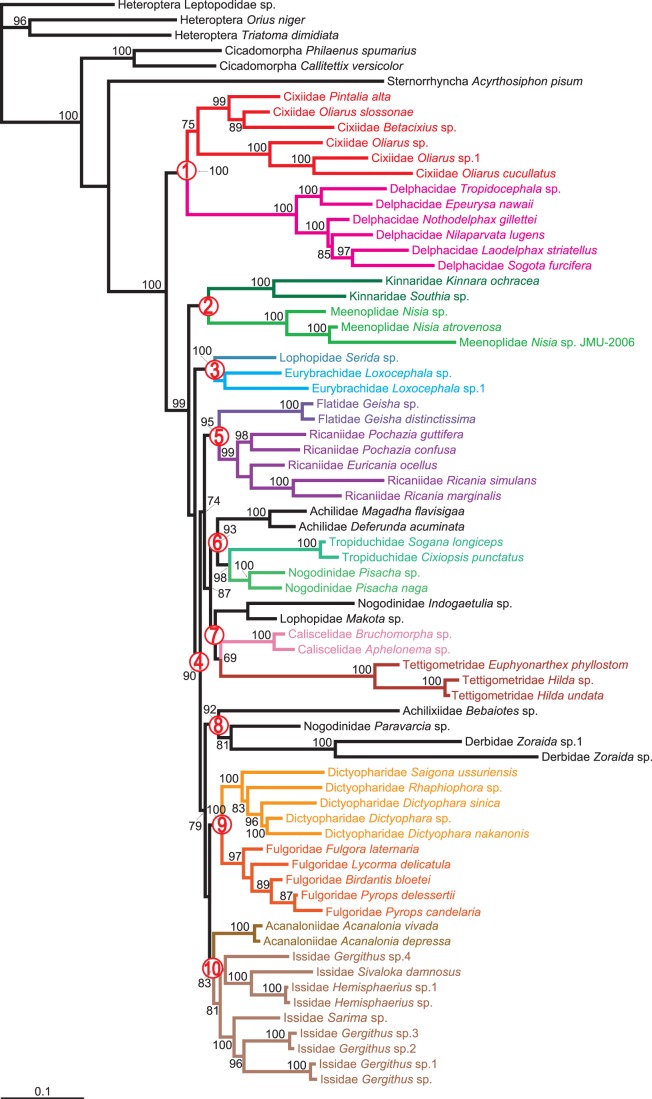
Maximum-likelihood tree estimated from the combined datatset of 65 taxa of Fulgoroidea.Values above branches denote ML bootstrap support (≥70). The red numbers in circles correspond to ten major clades discussed in the text.